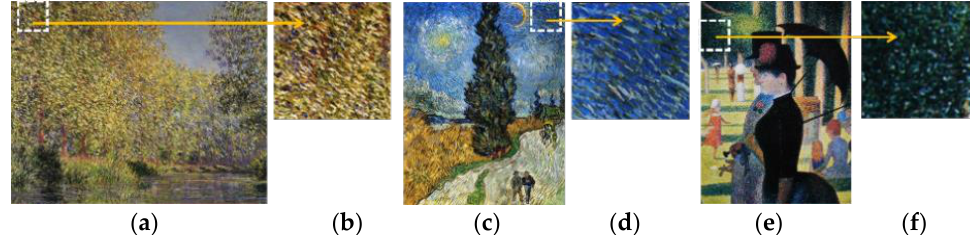
Figure 7. ( a ) Monet, “Bend in the Epte River near Giverny”, ( b ) Brush stroke image of ( a ), ( c ) Van Gogh, “Cypress against a Starry Sky”, ( d ) Brush stroke image of ( c ), ( e ) Seurat, “Models.Detail”, ( f ) Brush stroke image of ( e ).